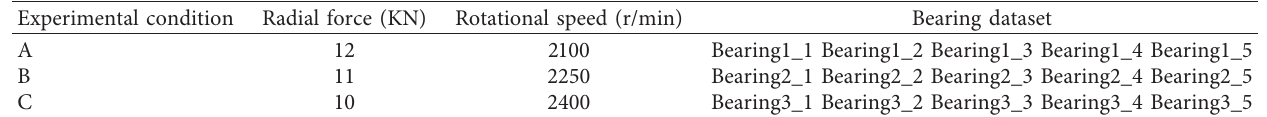
Table 1: Accelerated life condition of